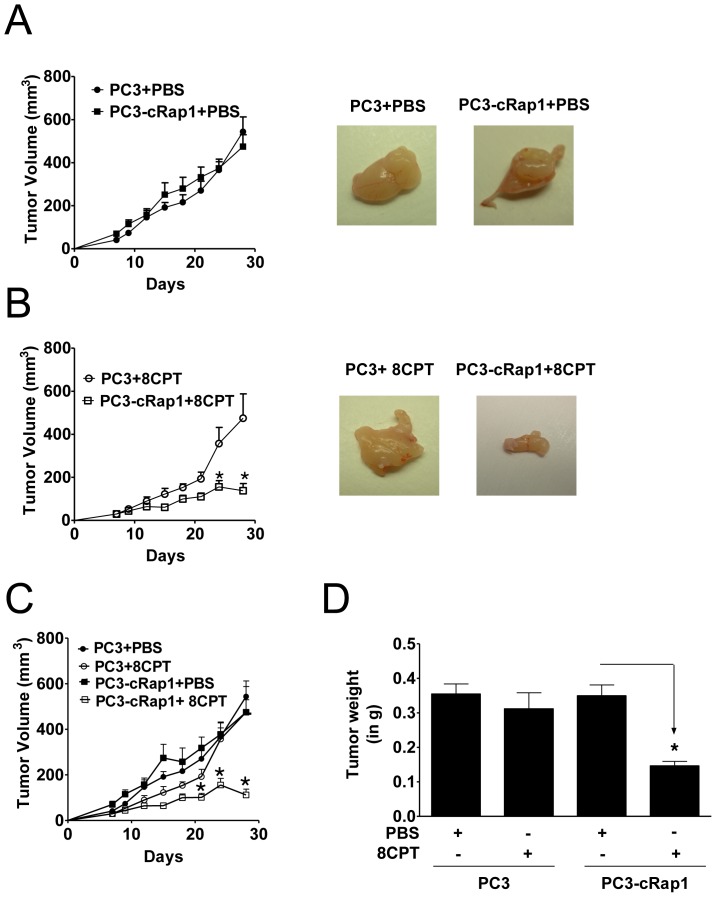
Effect of constitutive Rap1 expression (cRap1) and/or 8CPT treatment on PC3 xenograft growth.(A and B) Left Panel: Tumor volume (expressed in mm3) of human PC3 and PC3-cRap1 xenografts treated as indicated was measured as described in Methods. Day 0 represents the first day of treatment; *p<0.05, n = 7 for each group. Right Panel: Images of a representative tumor from each treatment group at the end of the experiment (Day 28). (C) Tumor volume (expressed in mm3) of human PC3 and PC3-cRap1 xenografts treated as indicated was measured as in A; *p<0.05, n = 7 for each group. (D) Tumors from panel C were weighed at the end of the experiment (Day 28) and expressed in grams; *p<0.05; (n = 7).